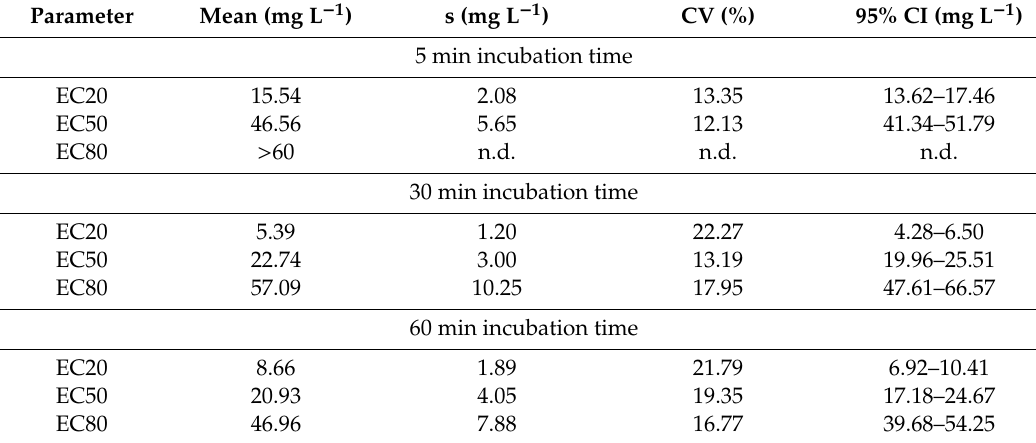
Table 3. Toxicity of Zn (II) at di ff erent incubation times, as determined by the modified method. The aim of the experiments was also the evaluation of the influence of the incubation time on the EC50 values. Furthermore, data for a comparison with the standard procedure were also provided. The number of repetitions was seven. s = standard deviation, CV = variation coe ffi cient, CI = confidence interval of the mean and n.d. = not determined.